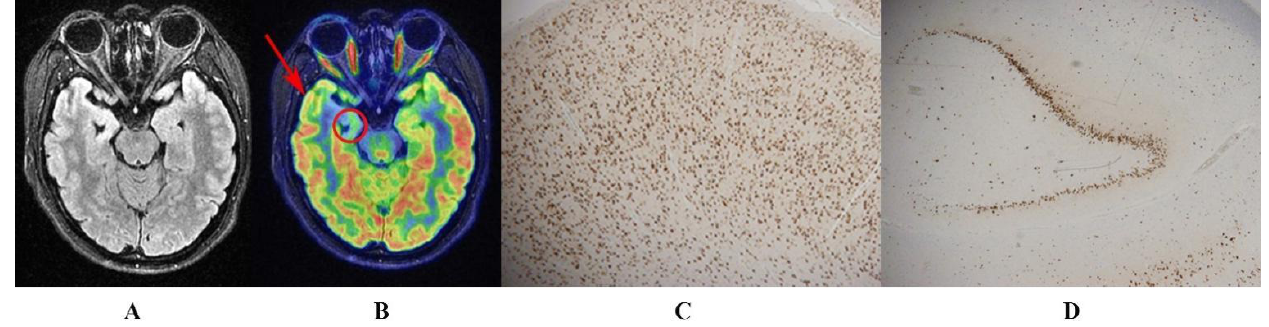
Figure 1. A 21-year-old woman with a history of seizures, onset at age 15. T2-FLAIR showed right hippocampal atrophy with a hyperintense signal ( A ). Hybrid 18 F-FDG PET/MR image indicated a well-defined area of focal hypometabolism in the right temporal lobe (arrow) and hippocampus (circle) ( B ). After a right anterior temporal lobectomy, the histopathological images with neuronal nuclear antigen immunostaining showed FCD type Ib in the right temporal lobe ( C ), and HS type I in the ipsilateral hippocampus ( D ). After a postoperative 2-year follow-up, the patient was classified as Engel Class IA.